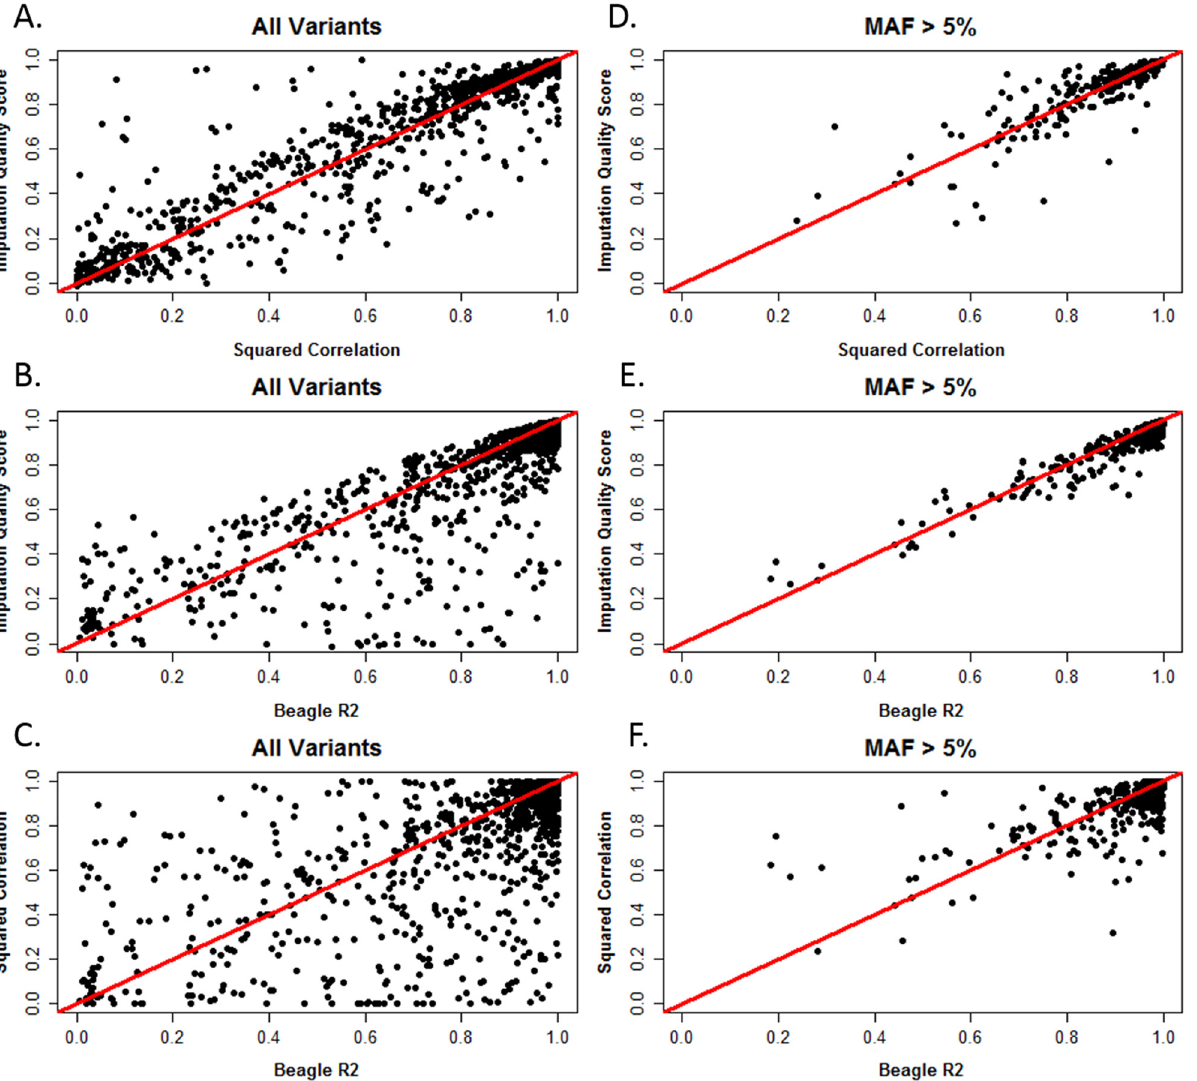
Fig 6. Scatterplots of IQS, squared correlation, and BEAGLE R 2 using the cosmopolitan reference panel and the African American nicotine dependence study sample for chromosome 15. Data for all 1,545 variants are displayed in panel A, B, and C while the results for variants with MAF > 5% (N = 631) are found in panel D, E, and F. These results were generated using Omni SNP coverage. The line y = x is denoted in